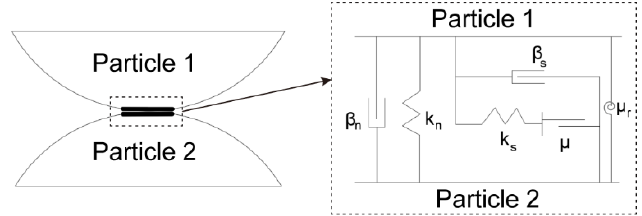
Figure 3. Schematic of the constitutive model of particle-particle